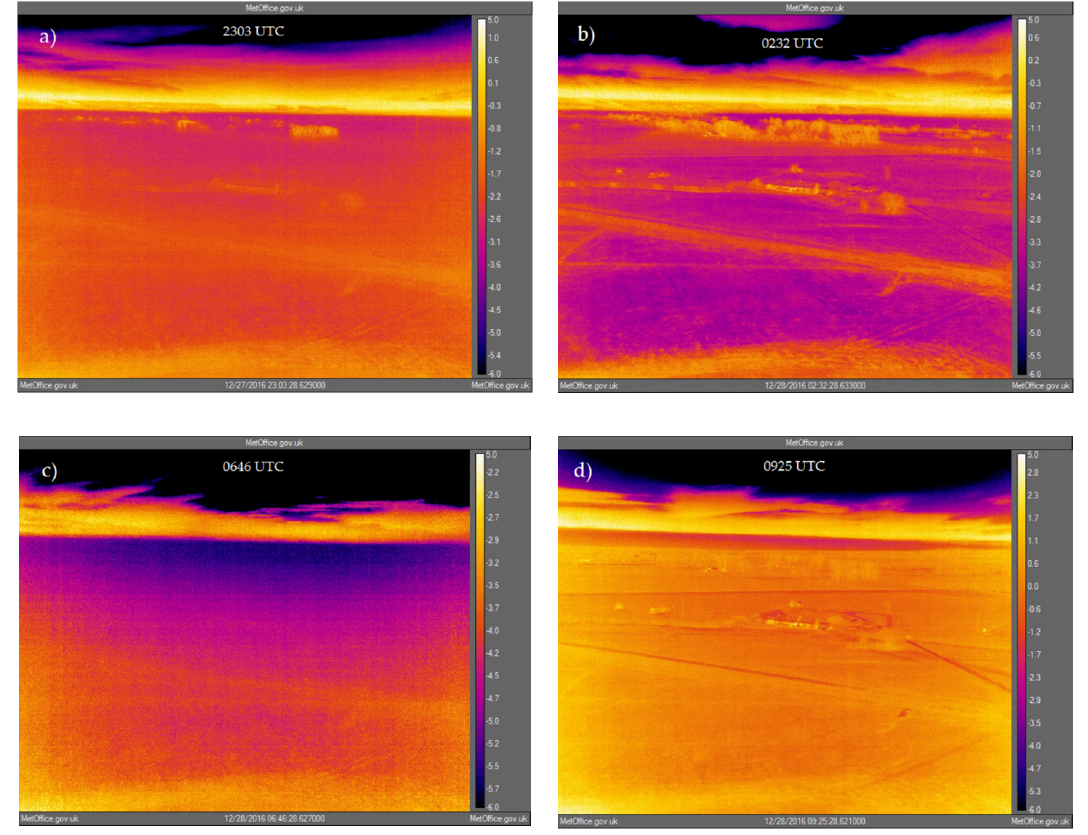
Figure 12. IR imagery for 27–28 December 2016 at ( a ) 2303 UTC, ( b ) 0232 UTC, ( c ) 0646 UTC and ( d ) 0925 UTC.